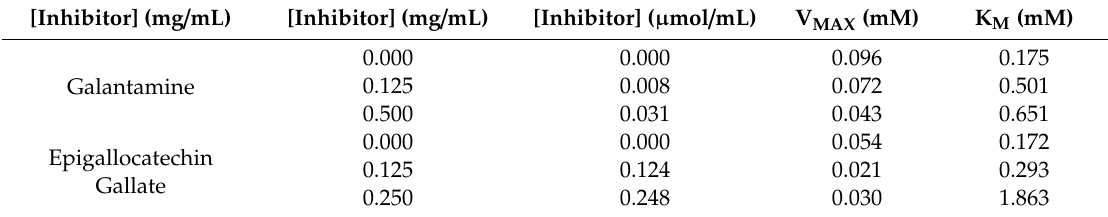
Table 11. Kinetic coe ffi cients.